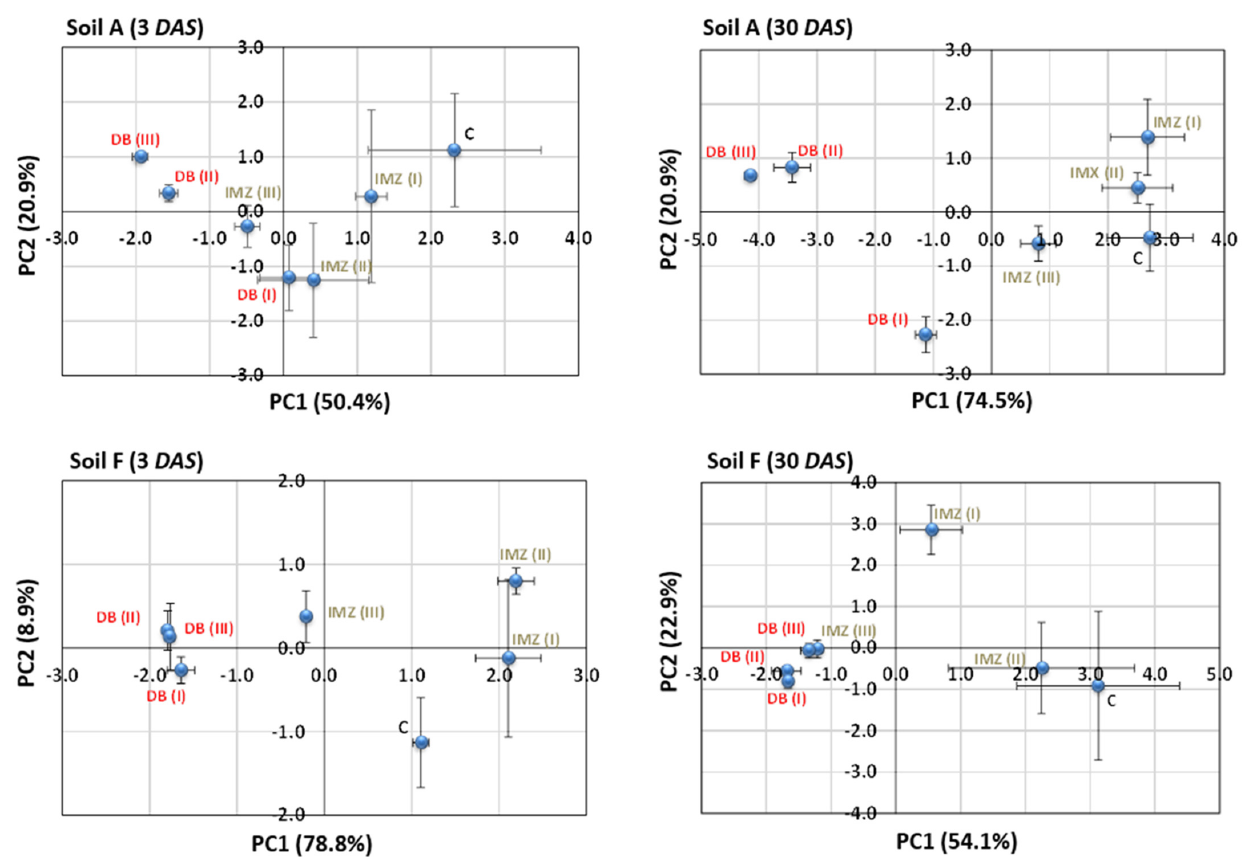
Figure 5. PCA plots of standardized C source utilization data of microbial communities extracted from soils treated with different imazamox (IMZ) and 2,4-DB (DB) concentrations at 3 and 30 days after herbicide spiking ( DAS ). IMZ(I), (II) and (III) refer to 3, 15, 150 µg IMZ g − 1 soil, respectively. DB(I), (II) and (III) refer to 100, 500, 5000 µg DB g − 1 soil, respectively. C, control (untreated) soil.